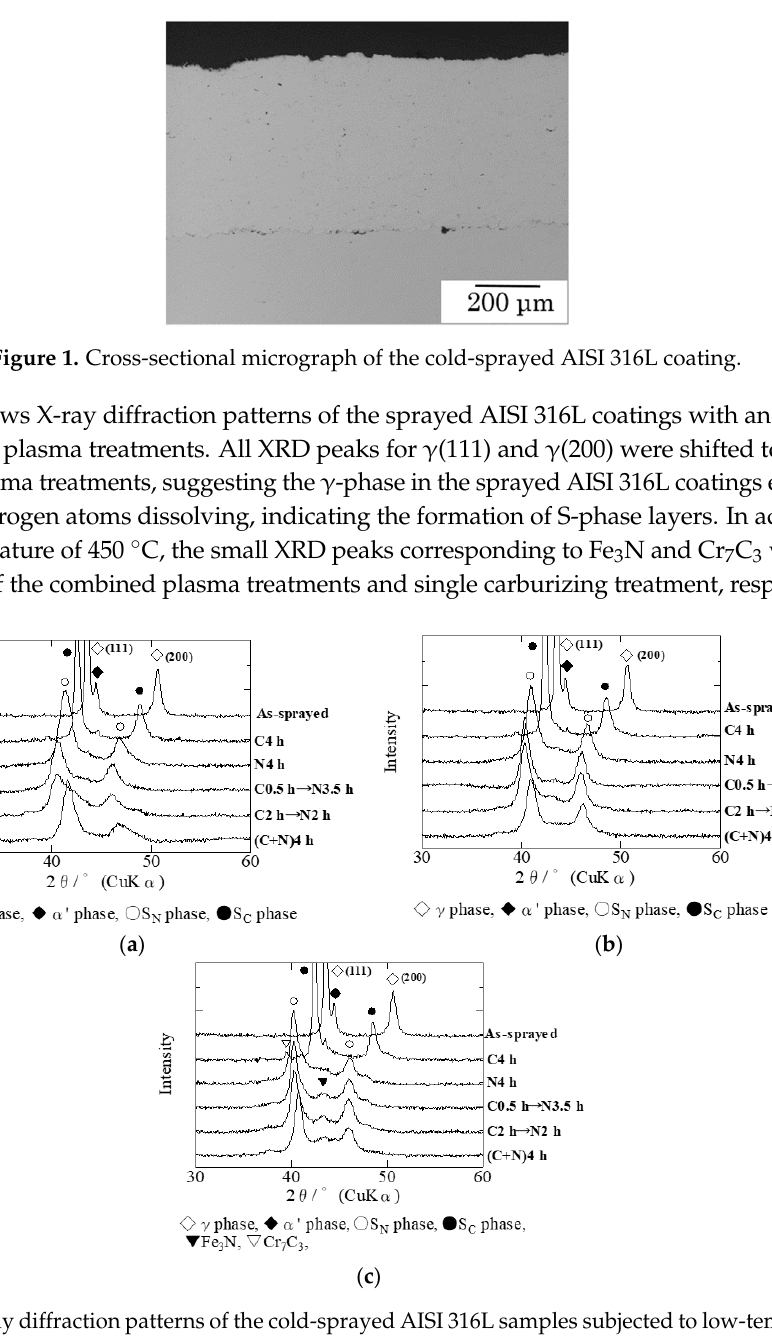
Figure 2. X-ray diffraction patterns of the cold-sprayed AISI 316L samples subjected to low- temperature plasma treatments at ( a ) 400 °C, ( b ) 425 °C and ( c ) 450 °C.